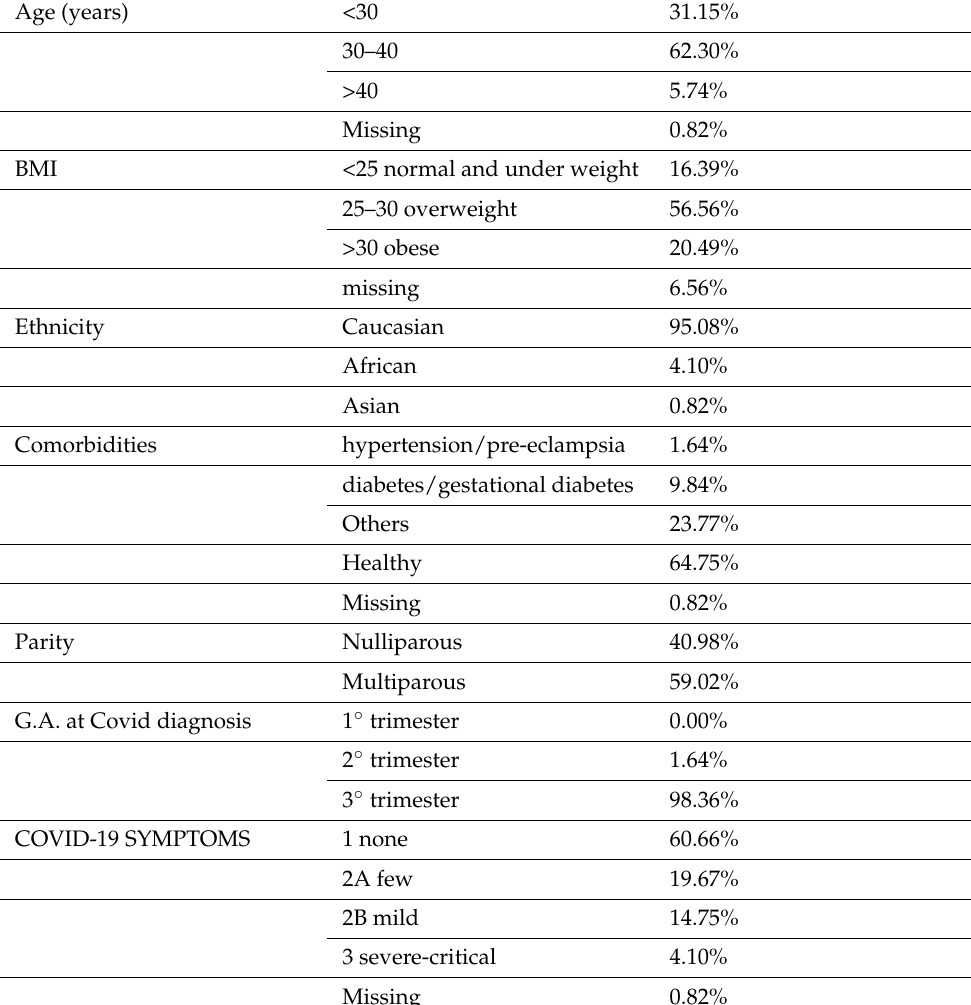
Table 1. General characteristics of the population (N 287).